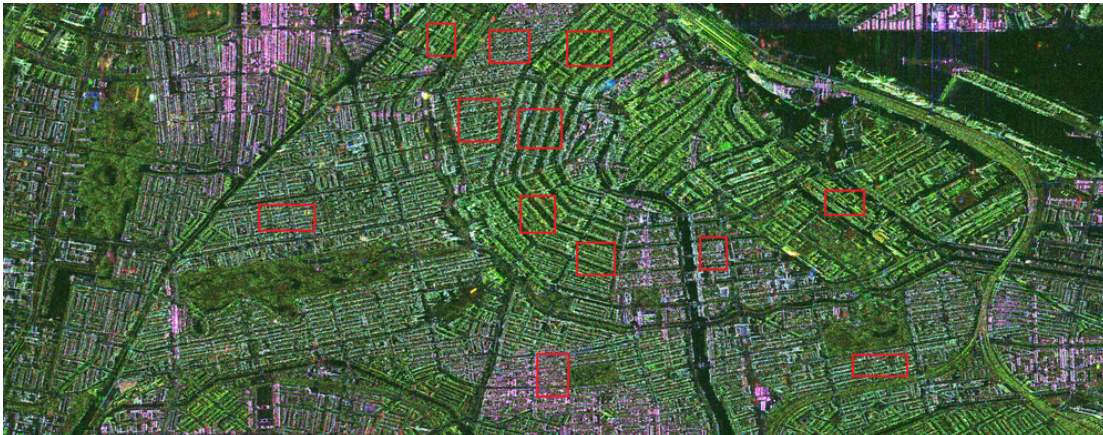
Figure 7. PolSAR image of New Orleans acquired by UAVSAR (L-band) in the Pauli basis. The sensor trajectory is parallel to the top of the figure. Red rectangles refer to selected areas.